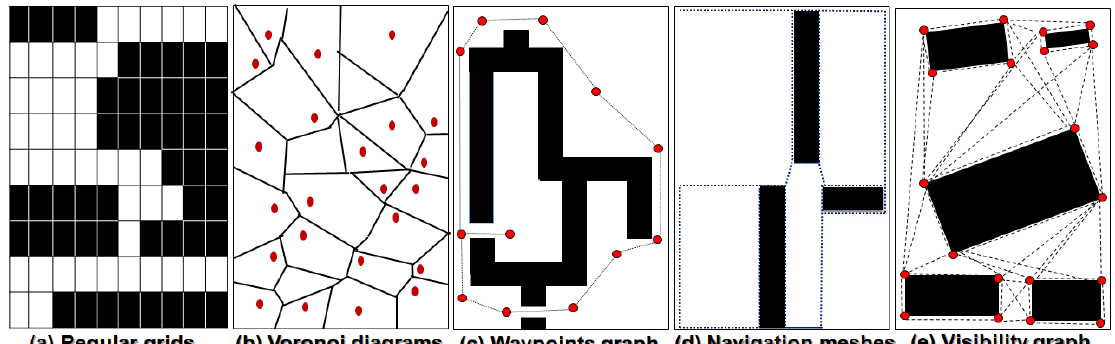
Figure 1. Most widely used environments representation techniques for global path